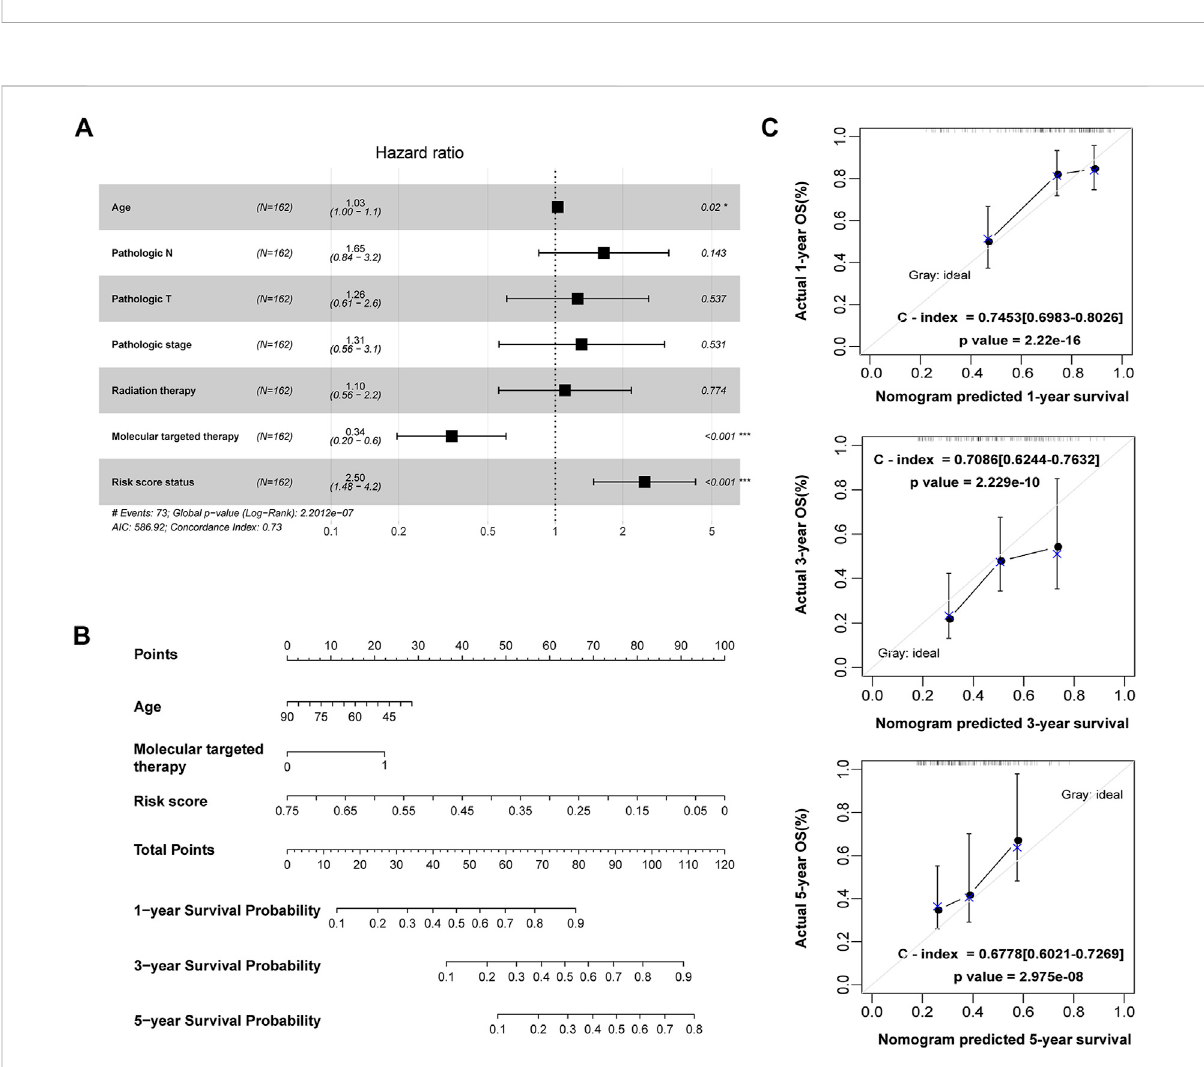
FIGURE 8 Construction of a nomogram for OS prediction in the TCGA PAAD dataset. (A) Forest plot of the multivariate Cox regression analysis of the risk scoreandclinicopathologicalparametersinPAAD.* p < 0.05,*** p < 0.001. (B) Thenomogramincorporatingriskscoreandclinicalfactorsforsurvival prediction in PAAD. (C) The calibration curve of the nomogram for predicting the 1-, 3- and 5-year OS rates of PAAD patients in the training cohort. The X -axis represents the predicted OS rates, and the Y -axis represents the actual OS rates. The dashed line at 45 ° indicates the ideal performance, and the C-index was calculated to re fl ect the predictive accuracy of the